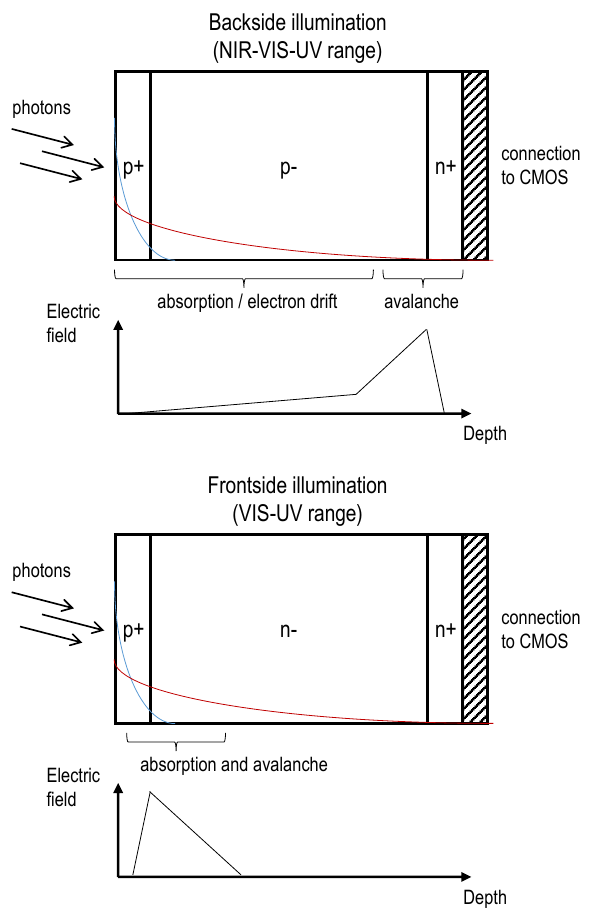
Figure 10. Illustration of typical backside and frontside illuminated SPADs including the different locations of the absorption/drift region, the avalanche region and a simplified electric field. The blue and red sketch lines roughly represent the typical light absorption distribution for short (UV-blue) and long (red-NIR) wavelengths,